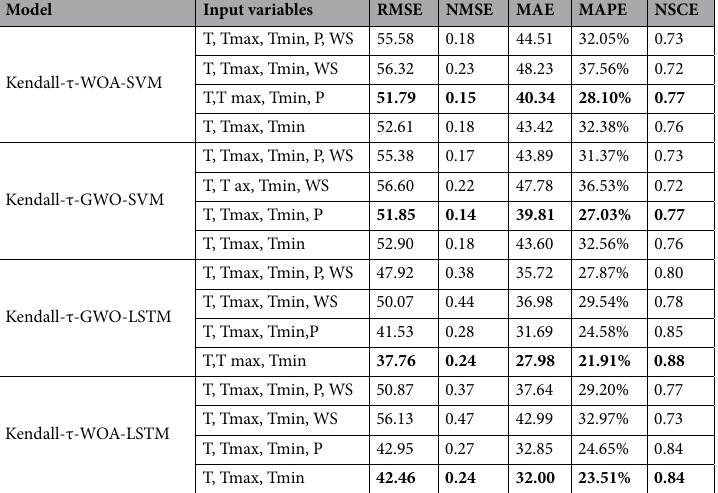
Table 10. The evaluation metrics average of the proposed models with different input combinations in testing